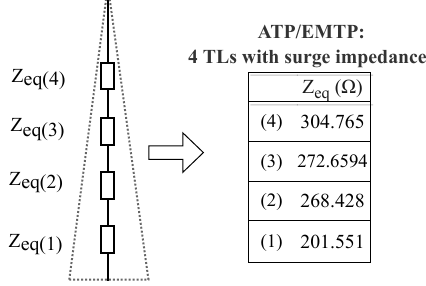
Figure 4. Schematic representation of the transmission tower